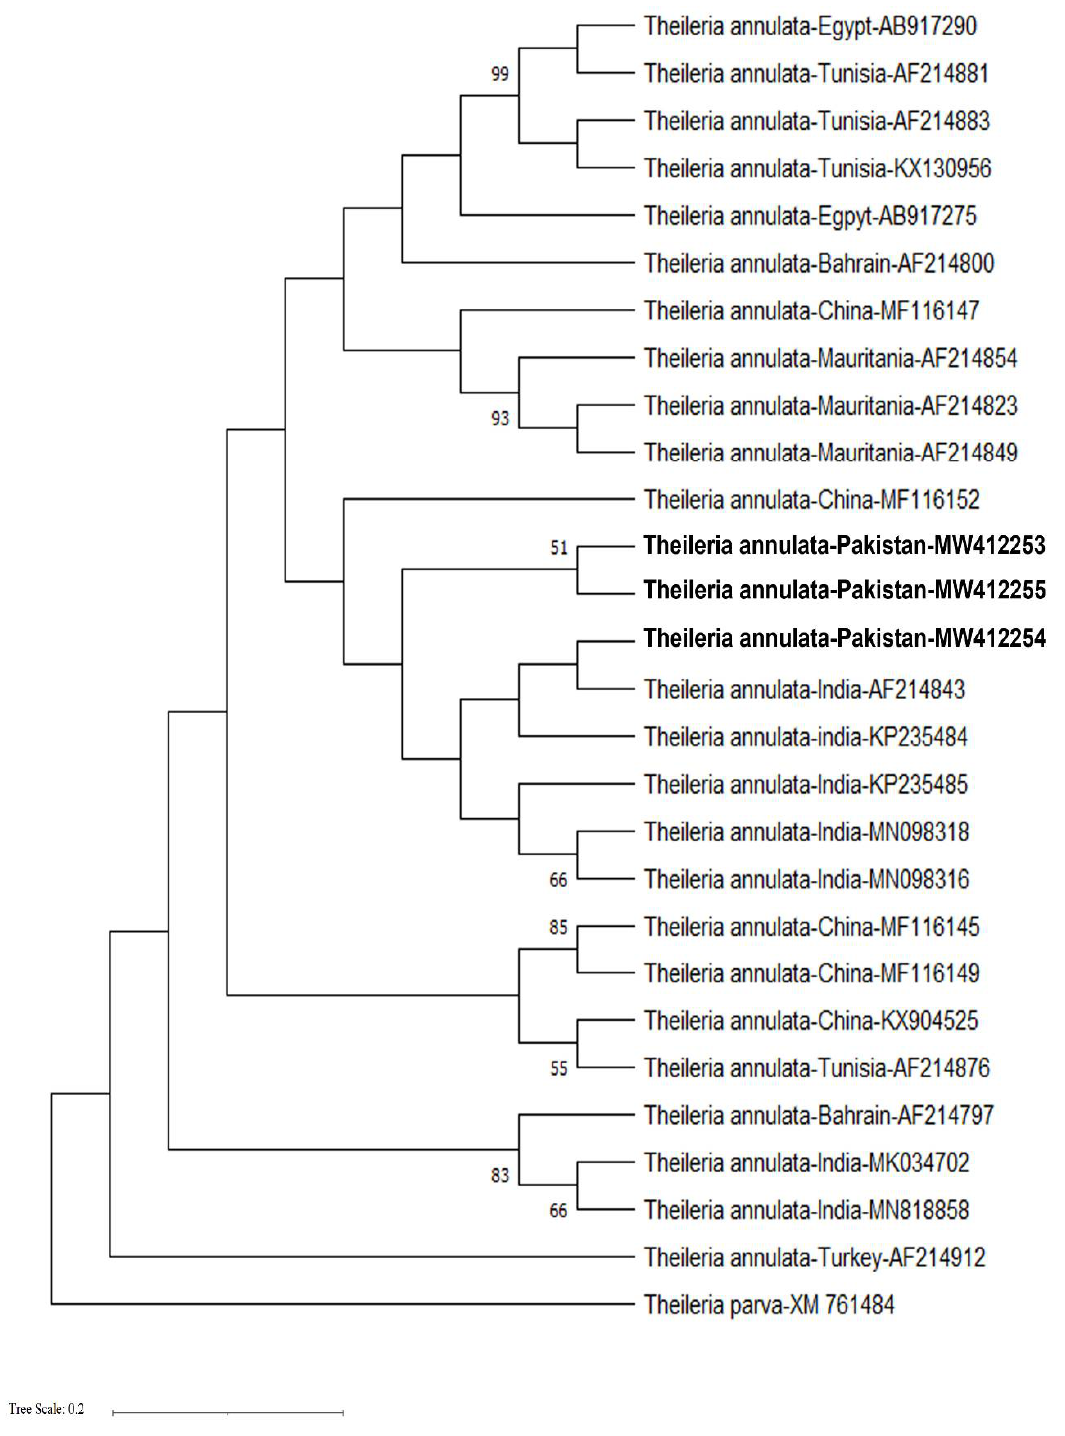
Figure 3. Phylogenetic tree based on partial 30 kDa gene sequences from T. annulata isolates from cattle in Pakistan and worldwide, available in GenBank. The evolutionary history was inferred using the neighbour-joining and BioNJ algorithms. Three new sequences of T. annulata obtained in the present study are represented in bold. The scale bar represents 0.2 substitutions per nucleotide position.